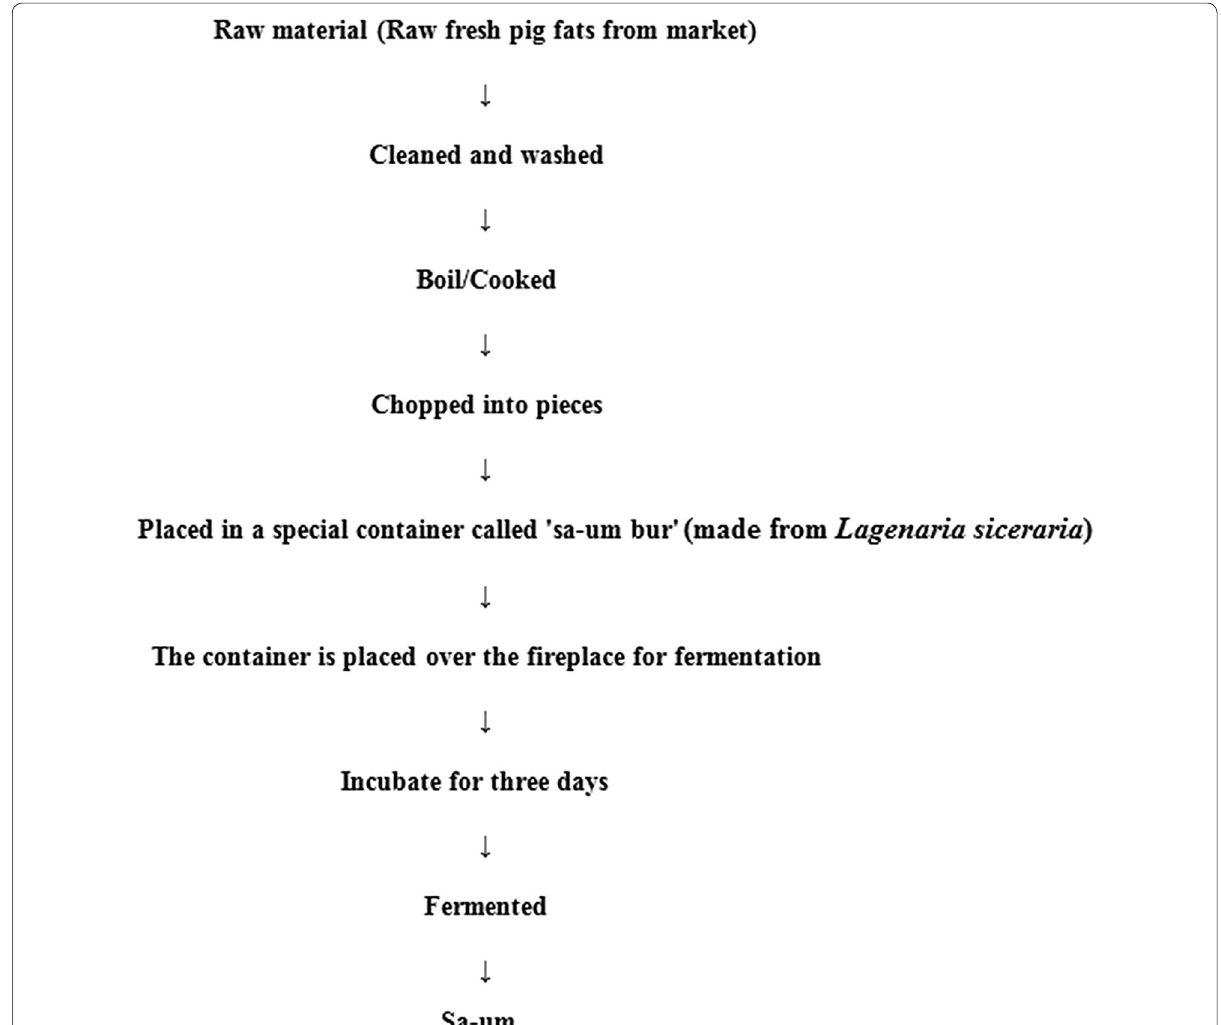
Fig. 1 Traditional method of sa - um